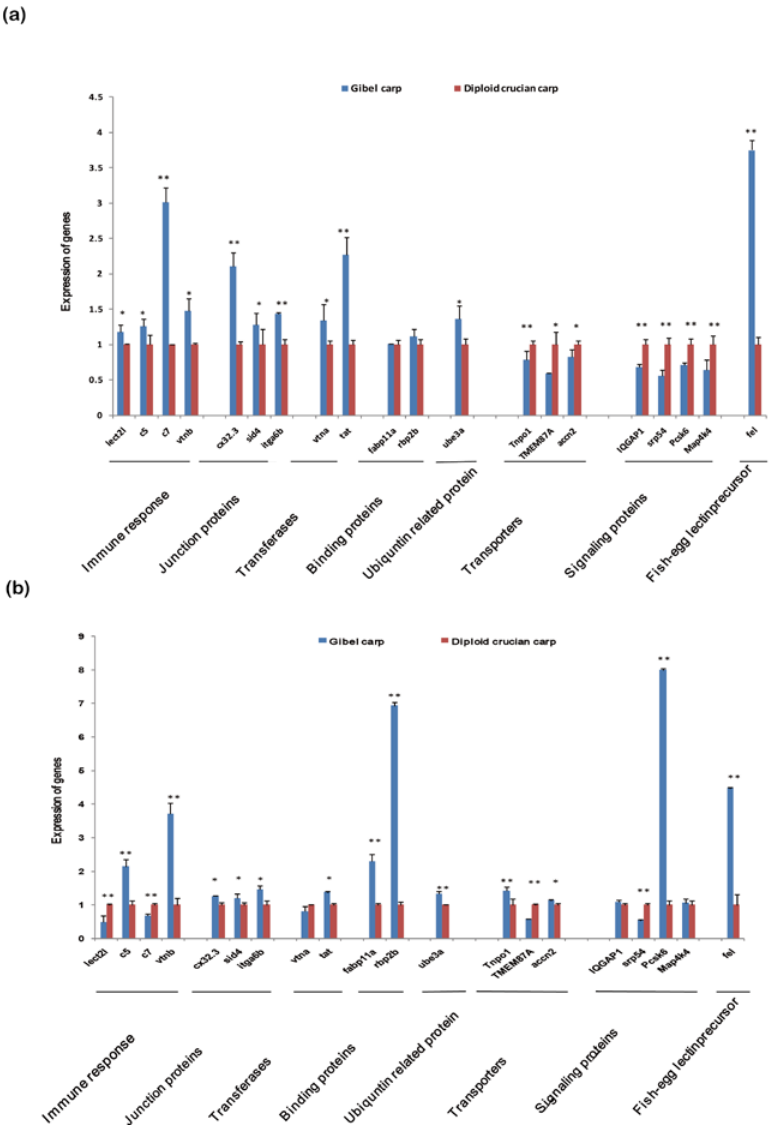
Figure 4. Differentially expressed genes validated by RT-qPCR. ( a ) The expression levels of 20 DEGs were quantified by RT-qPCR in pooled tissues of diploid crucian carps (red) and gibel carps (blue). The x -axis shows genes in different categories; the y -axis displays the gene expression level (Student’s t- test; * p < 0.05, ** p < 0.01). The expression patterns of most DEGs by RT-qPCR were similar to those in the RNA-Seq analysis; ( b ) The expression levels of 20 DEGs were quantified by RT-qPCR in gonads of diploid crucian carp (red) and gibel carps (blue) (Student’s t- test; * p < 0.05, ** p <